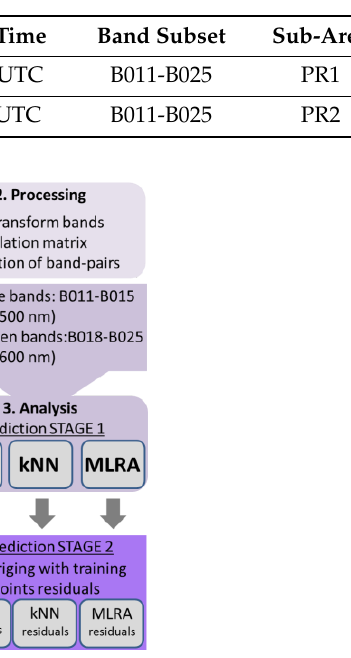
Figure 2. Schematic diagram of the workflow followed in this study. Table 1. Hyperion data details.